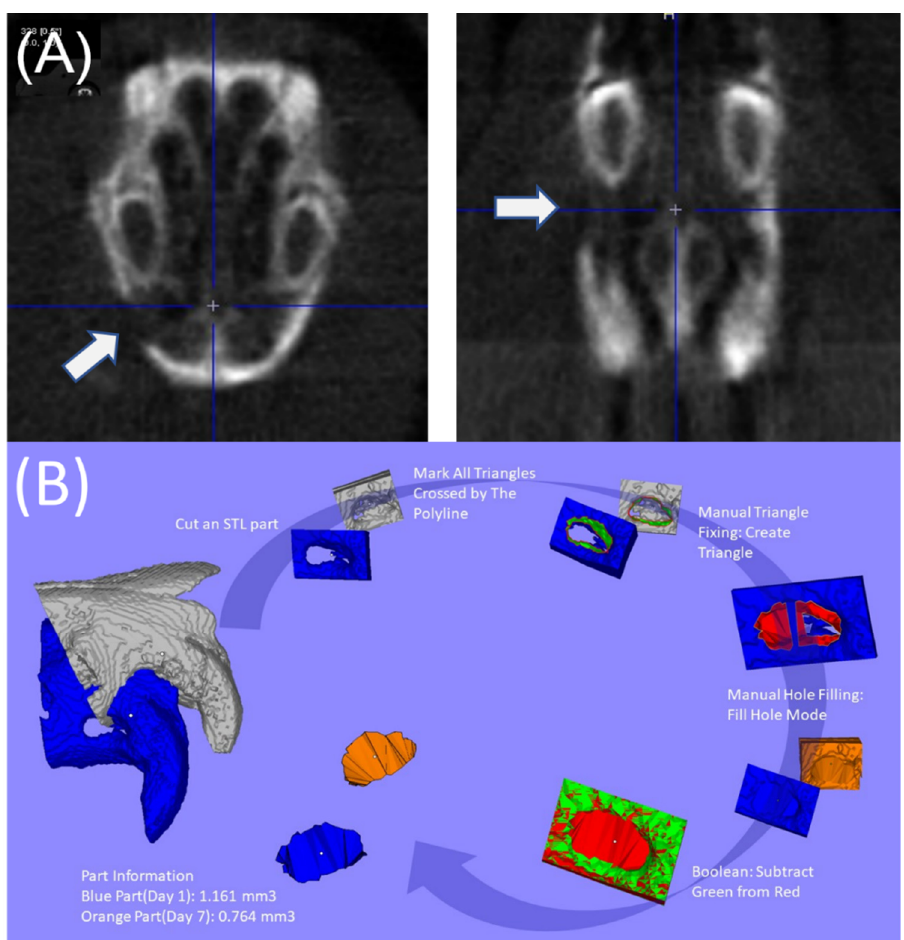
Figure 3. ( A ) Micro-CT scanning of the alveolar bone defect, ( B ) calculation of bone growth in the defect: segmentation of an area involving the defect (cid:58) incision in stereolithographic (STL) part (cid:58) marking of all triangles crossed by the polyline (cid:58) manual triangle fixation to create triangle (cid:58) manual hole filling with fill hone mode application of the Boolean method for defect volume.